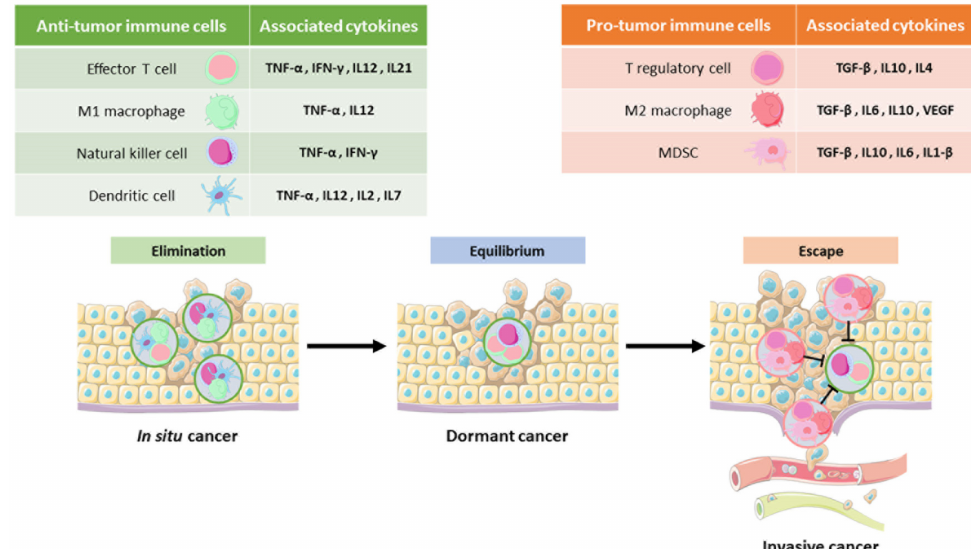
Figure 1. The 3 phases of the immunoediting process in cancer. Once solid tumors reach a defined size, inflammatory signals attract innate immune cells (dendritic cells, M1 macrophages and natural killer cells) which then activate effector T cells by the secretion of associated cytokines (e.g., TNF- α , IFN- γ , IL2, IL7). This process called immunosurveillance (left) detects and eliminates tumor cells by releasing cytotoxic molecules. The tumor then enters an equilibrium phase (middle) in which its growth is maintained by the secretion of IFN- γ but not sufficiently to avoid the appearance of mutations. The cells then become uncontrolled; this is the setting up of the escape process (right). The recruitment of immunosuppressive cells (MDSC, M2 macrophages and T regulatory lymphocytes), through the release of protumor mediators (e.g., TGF- β , IL4, IL10, VEGF), contributes to the uncontrolled growth of the cancer and to the exhaustion of antitumor cells. IFN- γ :